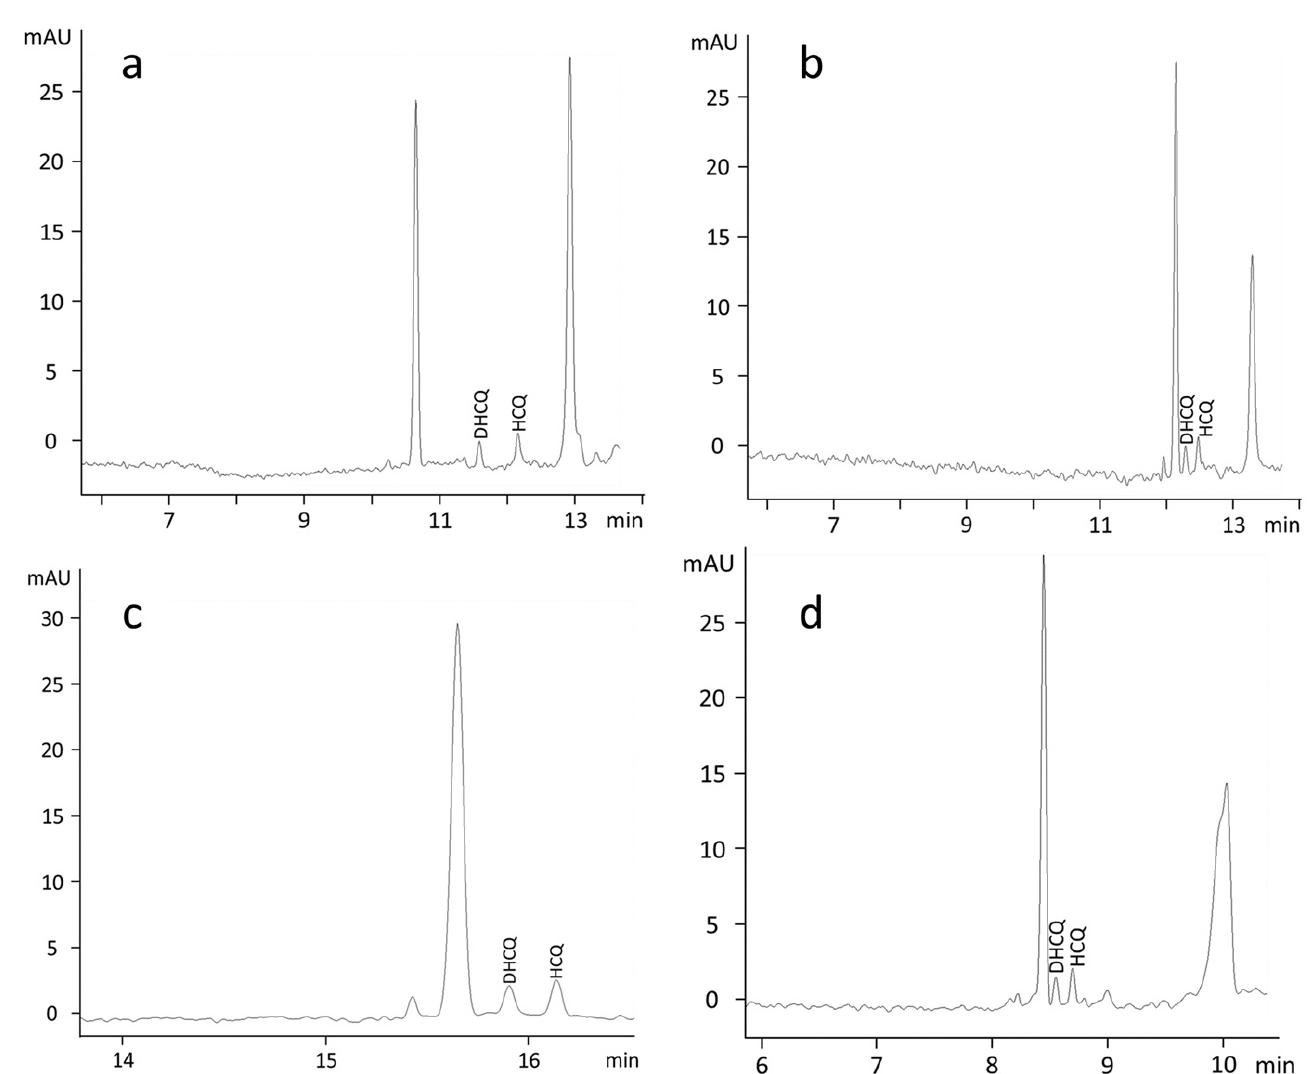
Figure 1. Electropherograms of a clinical sample obtained using as a BGE, ( a ) a 100 mmol/L TRISH solution at pH 4.5 and a separation voltage of 15 kV at a temperature of 30 °C, ( b ) a 100 mmol/L TRIS solution brought to pH 4.5 with H 3 PO 4 and a separation voltage of 15 kV at a temperature of 30 °C, ( c ) a 55 mmol/L TRIS solution brought to pH 2.6 with H 3 PO 4 and a separation voltage of 15 kV at a temperature of 30 °C, and ( d ) a 55 mmol/L TRIS solution brought to pH 2.6 with H 3 PO 4 and a separation voltage of 20 kV at a temperature of 30 °C.